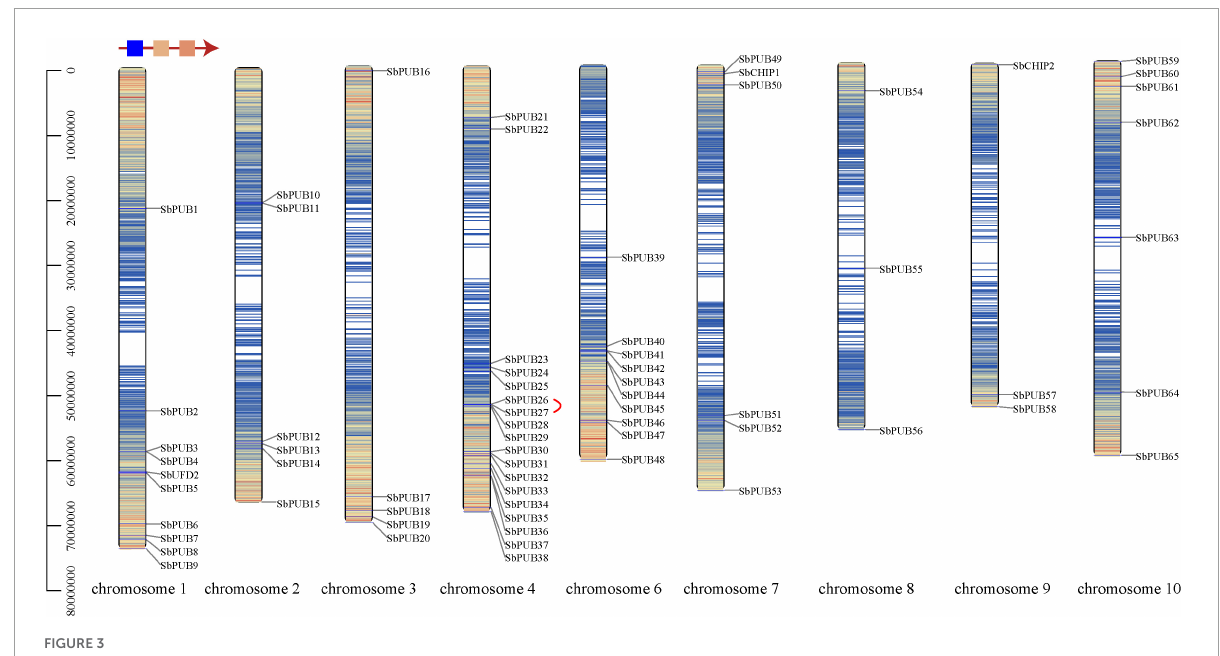
FIGURE3 Chromosome location of U-box genes in Sorghum. The different colors of chromosomes represent gene density in this range, and variation is indicated in the upper left corner. Red lines represent tandem